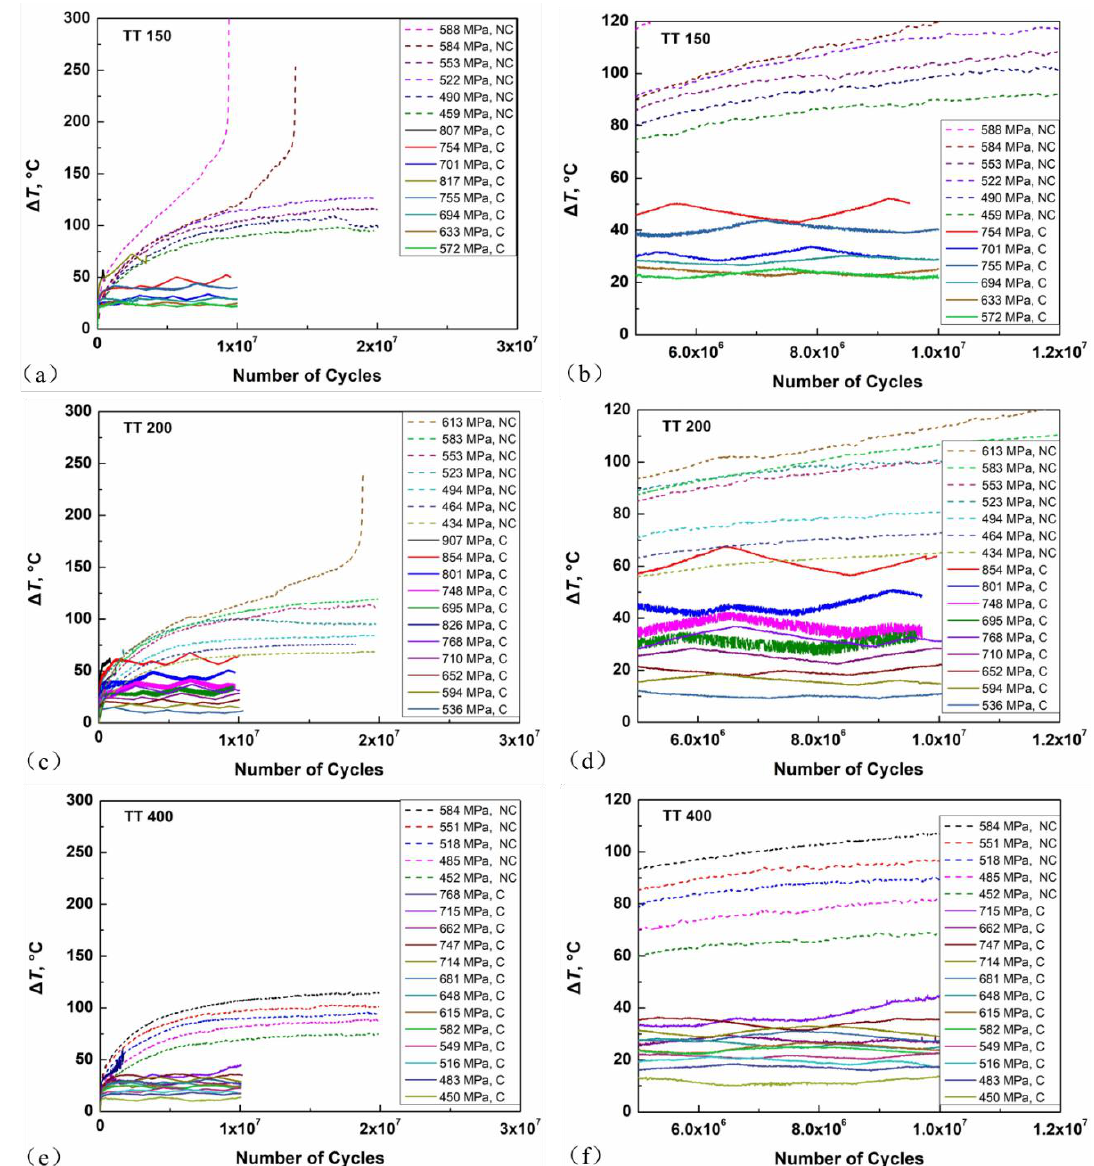
Figure 5. Temperature rise of UA and ultrasonic axial loading without cooling (UA-NC) specimens under different loading stresses for three material conditions. ( a ) TT 150; ( b ) enlargement of stable stage in a ; ( c ) TT 200; ( d ) enlargement of stable stage in c ; ( e ) TT 400; ( f ) enlargement of stable stage in e . (C: Cooling, NC: No Cooling).